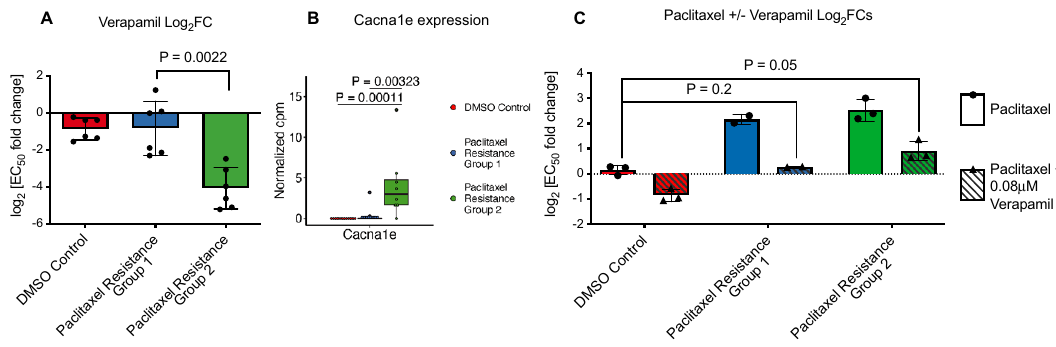
Figure 6. Paclitaxel resistance group 2 cell lines are collaterally sensitive to verapamil, and all paclitaxel resistant lines efflux paclitaxel. (A) Log 2 FC of verapamil EC 50 s, relative to the parental cell line. P-value is shown for Mann–Whitney test comparing paclitaxel resistance group 1 and group 2. (B) TMM-normalized counts for Cacna1e. FDR-corrected P-values are shown for post-hoc Dunn’s test of the indicated comparisons. FDR correction was performed across all genes with a significant Kruskal–Wallis test and significant post-hoc Dunn’s test including those in Fig. 5E. See Supplementary Table S4 for all genes tested. (C) Log 2 FC of paclitaxel EC 50 s, relative to the parental cell line with and without addition of 0.08 μM verapamil. P-values are shown for one- sided Mann–Whitney tests comparing paclitaxel resistance group 1 and paclitaxel resistance group 2 to